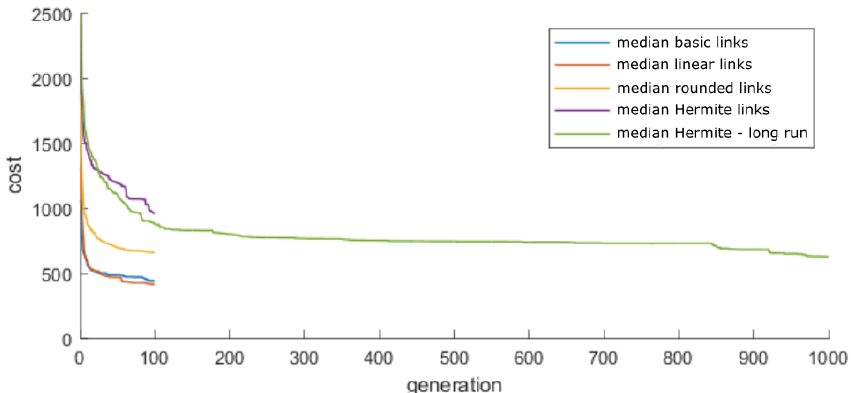
Figure 15. Results for a longer run of Hermite spline links for task 2 and function cost 1 .